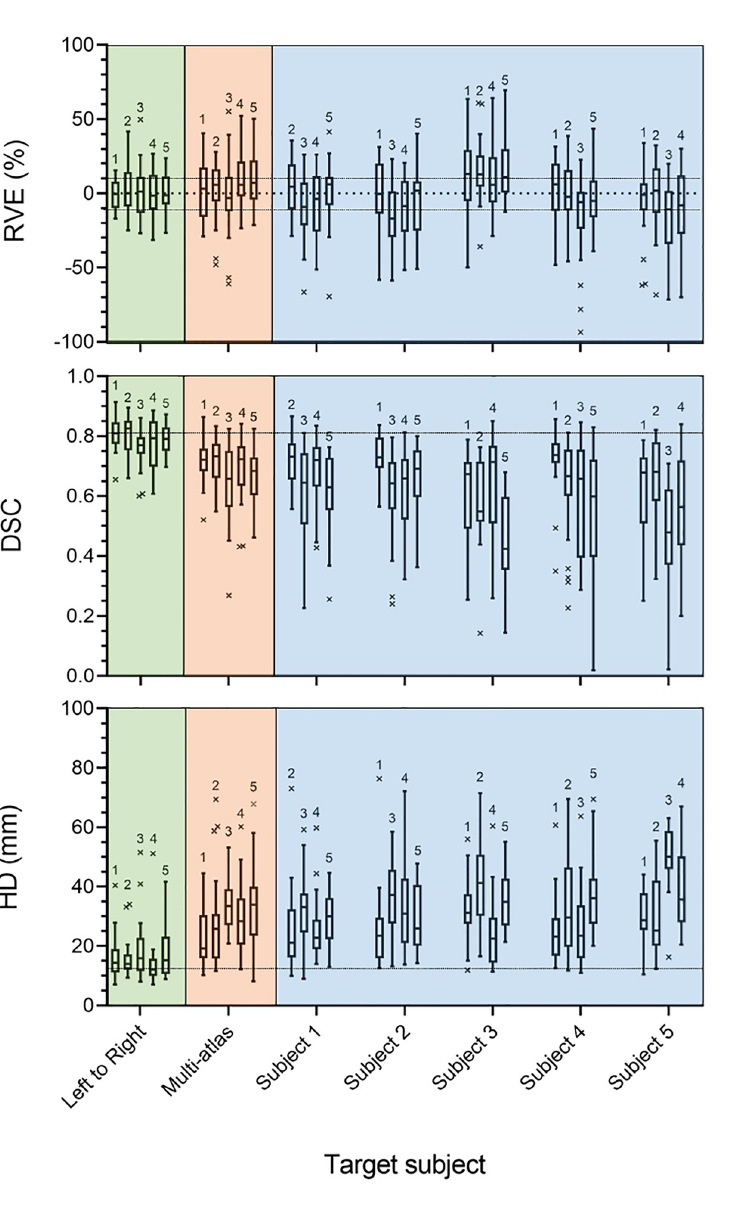
Fig 5. Numerical results for the intra-subject, multi-atlas, and single atlas analyses. Relative volume error (%) (top), Dice similarity coefficient (centre), and Hausdorff distances (mm) (bottom) found for each muscle in each subject, for the left to right analysis (green), multi-atlas (orange), and inter-subject approaches (blue). In both the left to right and multi-atlas analysis, the numbers above the boxplots denote the subject segmented. The numbers above each of the boxplots in the inter-subject approaches denote the reference subject used within the registration. The dashed line in RVE plot shows the acceptable level of RVE resulting from inter-operator dependence, prescribed by Montefiori et al. 2020 [15]. The grey dashed lines in the DSC and HD plots represent the mean values from the intra- subject analysis for comparison. The box and whisker plots show the mean, interquartile ranges, and ranges across the 23 muscles